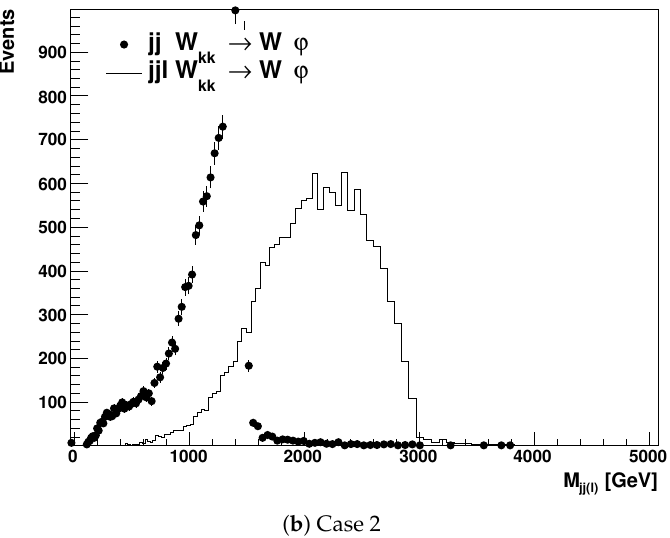
Figure 4. The m jj and m jjl invariant mass distributions for the 3 TeV Wkk mass when ( a ) case 1 : − M ϕ = 250 GeV & ( b ). Case 2 : M ϕ = M M W kk